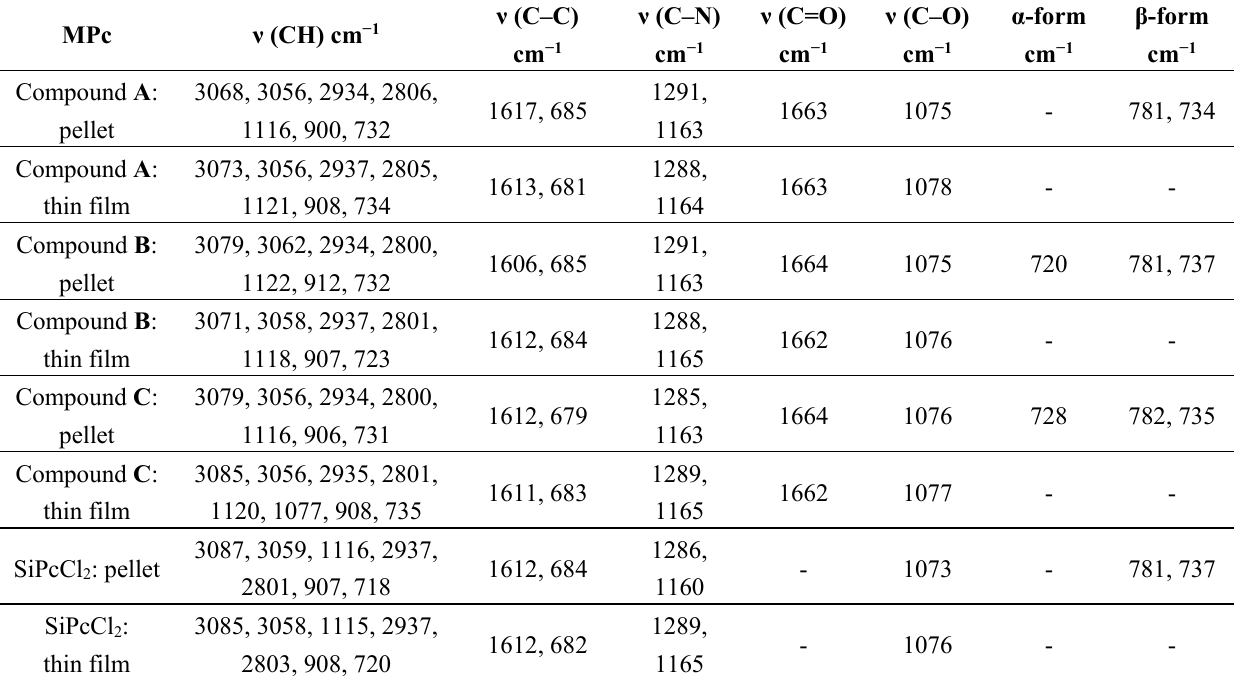
Table 1. Characteristic Fourier transform infrared spectroscopy (FTIR) bands for KBr pellets and thin films (cm − 1 ). MPc: metal phthalocyanines; and SiPcCl 2 : chloro ligands of SiPc